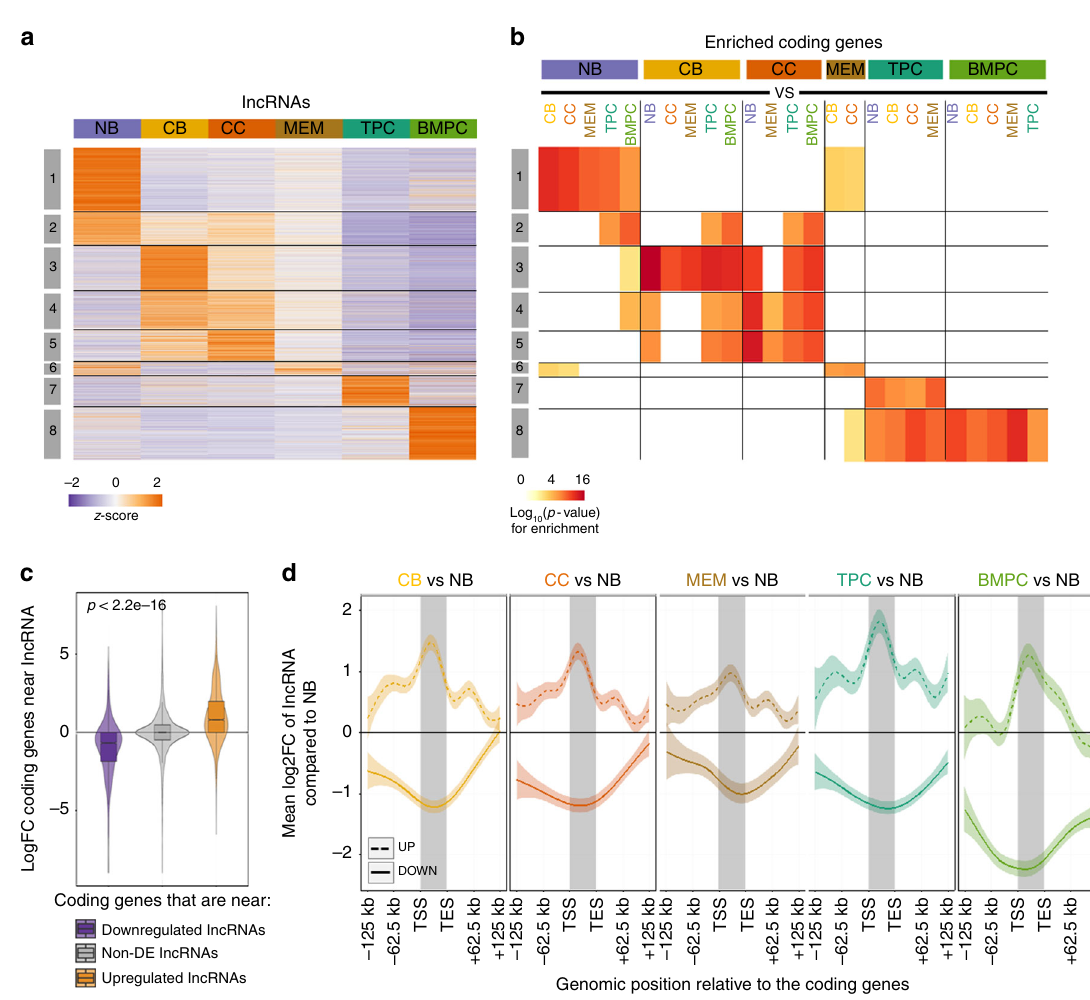
Fig. 4 Dynamic expression of long non-coding RNAs (lncRNAs) in the germinal center (GC) reaction. a Heatmap showing k -means clustering of speci fi c lncRNAs of each B cell subpopulation indicating dynamic modulation patterns of lncRNAs across different B cell subtypes. b Plot showing the expression of protein-coding genes that are adjacent to lncRNAs speci fi cally expressed in each B cell subpopulations. The enrichment of differentially upregulated genes near lncRNA clusters is shown. c Plot showing the average expression of protein-coding genes that are adjacent to lncRNAs that are differentially expressed in comparison between two B cell subpopulations ( p < 2.2 × 10 − 16 by Wilcoxon's rank-sum test). Box plots show the median as center, fi rst, and third quartiles as the box hinges, and whiskers extend to the smallest and largest value no further than the 1.5× interquartile range (IQR) away from the hinges. d Expression and localization of lncRNAs in relation to protein-coding genes up- or down-regulated. The changes in lncRNAs expression are shown by their proximity to coding genes that are differentially expressed in different stages. NB: naive B cells; CB: centroblasts; CC: centrocytes; MEM: memory B cells; TPC: tonsillar plasma cells; BMPC: plasma cells from bone marrow of healthy